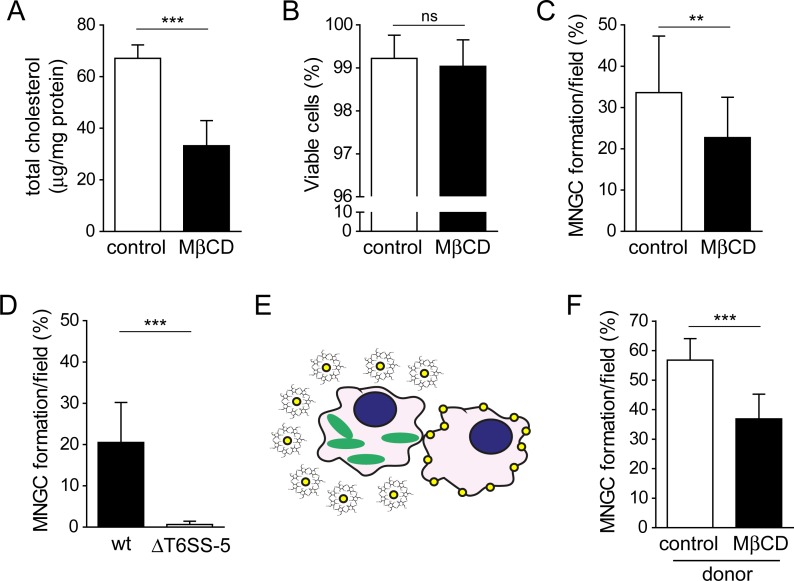
Acute treatment of RAW264.7 macrophages with the cholesterol extracting agent MβCD during infection decreases B. thailandensis mediated host cell fusions.A) Measurement of total cholesterol content of untreated (control) macrophages and cells treated with 10 mM MβCD for 1 h (MβCD) normalized to total protein content. Data are shown as mean + SD of two independent experiments performed in duplicate. ***, P < 0.0001 (t-test)/effect size: 4.327 (Hedges’ g). B) Viability of macrophages immediately after treatment with 10 mM MβCD for 1 h compared to untreated cells. Data represent mean + SD of two independent experiments performed in duplicate. ns, not significant P = 0.0438 (t-test)/effect size: 0.323 (Hedges’ g). C) MNGC formation of macrophages infected with B. thailandensis at an MOI of 17 and treated with 10 mM MβCD for 1 h shortly before the onset of MNGC formation. Shown are mean values + SD of four independent experiments performed in duplicate. **, P = 0.0027 (t-test)/effect size: 0.916 (Hedges’ g). D) MNGC formation induced by B. thailandensis wild type (wt) and ΔT6SS-5 mutant of macrophages infected and treated as described in C. Data shown are mean values + SD of two independent experiments performed in duplicate. ***, P < 0.0001 (Welch’s t-test)/effect size: 1.454 (Glass’s Δ). E) Schematic illustrating MβCD-based cholesterol extraction from infected donor cells. Green shape represents bacteria, yellow circles indicate cholesterol and the thin black lines denote ring-shaped heptamers formed by MβCD. F) MNGC formation of macrophages infected with B. thailandensis at MOI 33 for approximately 6 h and followed by MβCD (10 mM) treatment for 1 h. To these cells untreated and uninfected macrophages were added at equal ratios and MNGC formation was determined at 2–3 h post seeding. Data represent mean + SD of two independent experiments performed in duplicate. ***, P < 0.0001 (t-test)/effect size: 2.542 (Hedges’ g).